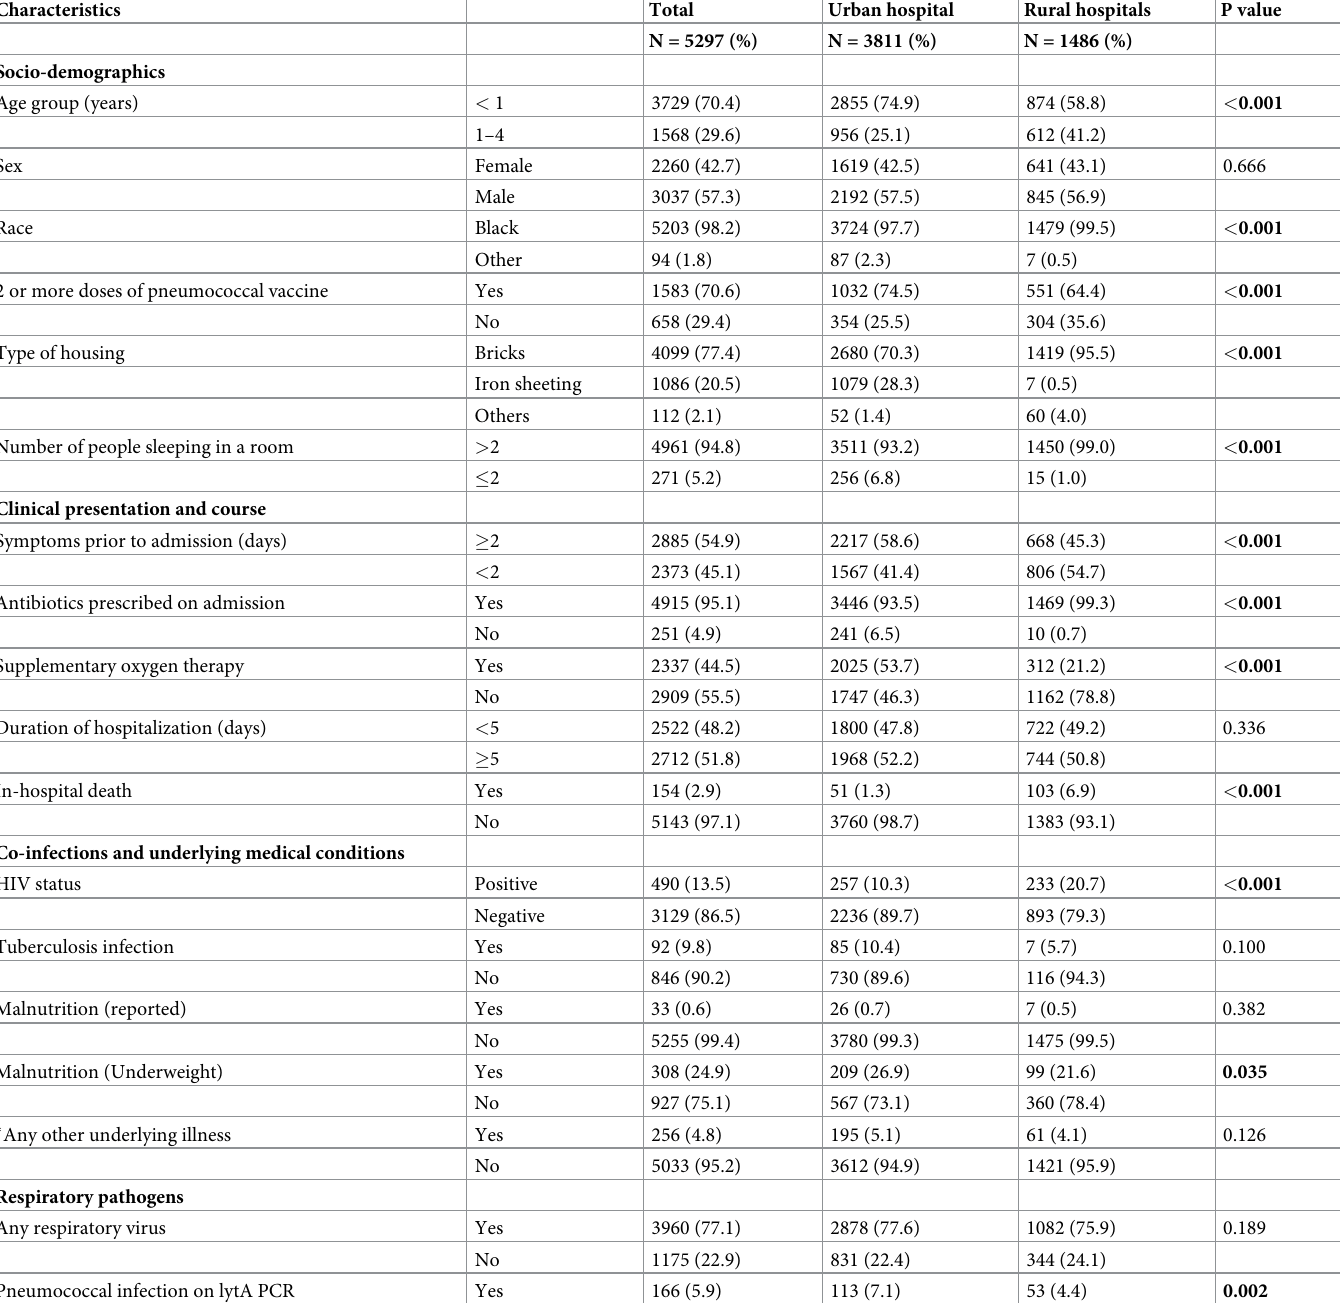
Table 1. Comparison of the demographic characteristics, clinical presentation and respiratory pathogens detected among children aged < 5 years hospitalized with SARI at urban and rural hospitals, South Africa 2009–2013.